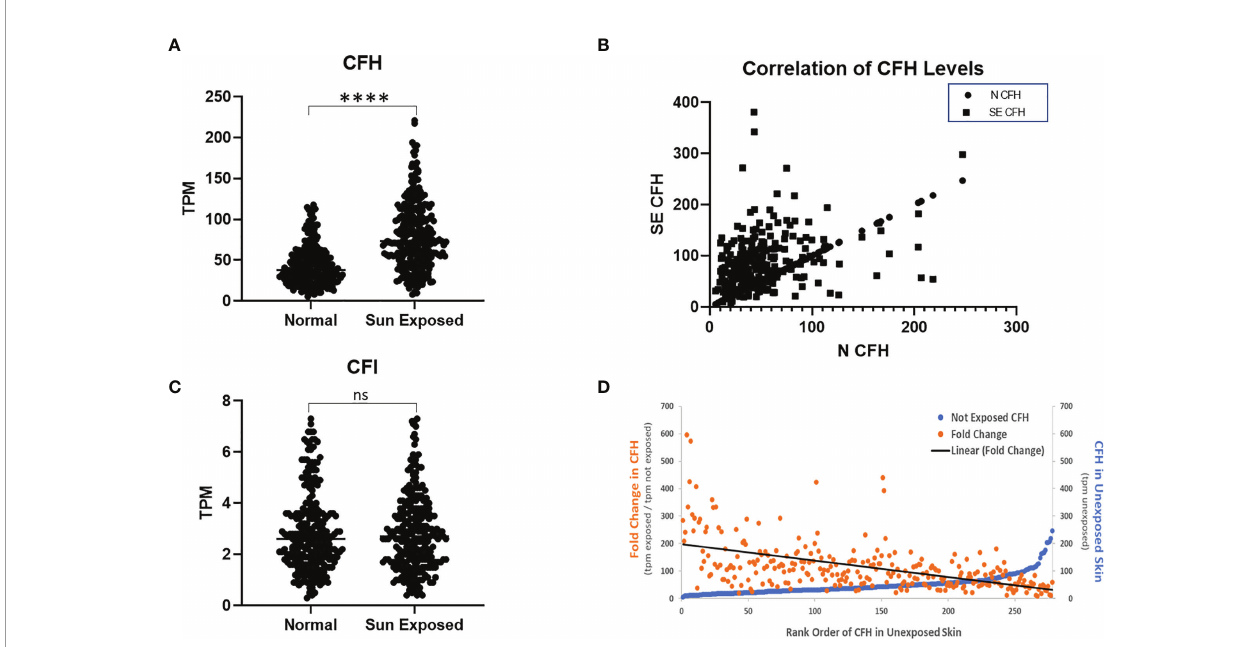
FIGURE 1 | CFH Transcript Number is Increased in Sun-Exposed Skin. GTEx data of 278 paired sun exposed (lower leg) and non-sun exposed (suprapubic) patient samples were analysed. CFH levels are increased in exposed skin (p<0.0001, two-tailed Wilcoxon matched-pairs signed rank test) but not CFI (A, C) . Levels of CFH mRNA (TPM) in exposed skin correlates with unexposed skin (p<0.0001, Spearman ’ s rank-order correlation) (B) . When sorted by non-exposed CFH levels, the levels and fold increase in paired exposed samples decreases with the exception being at the highest values of CFH in non-exposed skin (D) . (****p<0.0001; ns, not signi fi